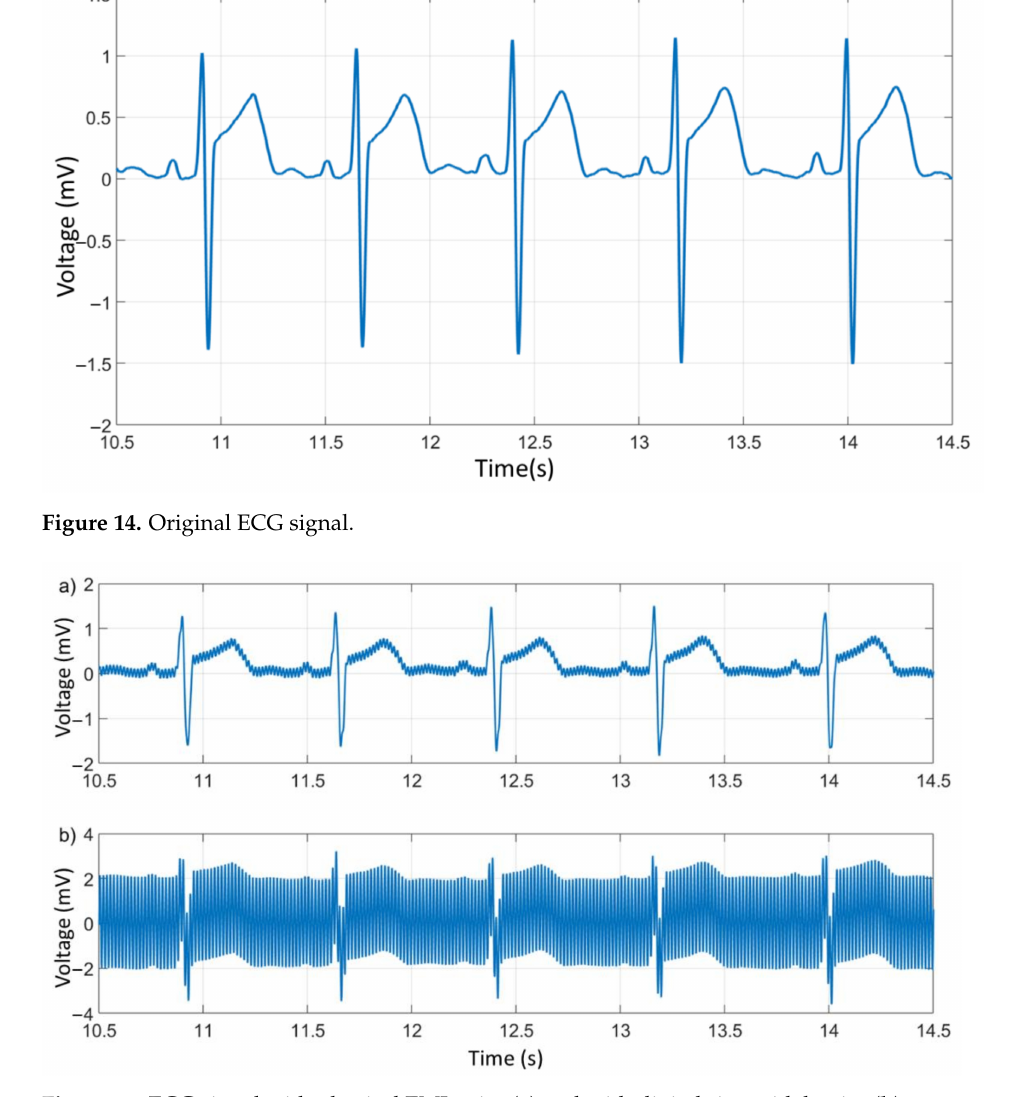
Figure 15. ECG signal with physical EMI noise ( a ) and with digital sinusoidal noise ( b